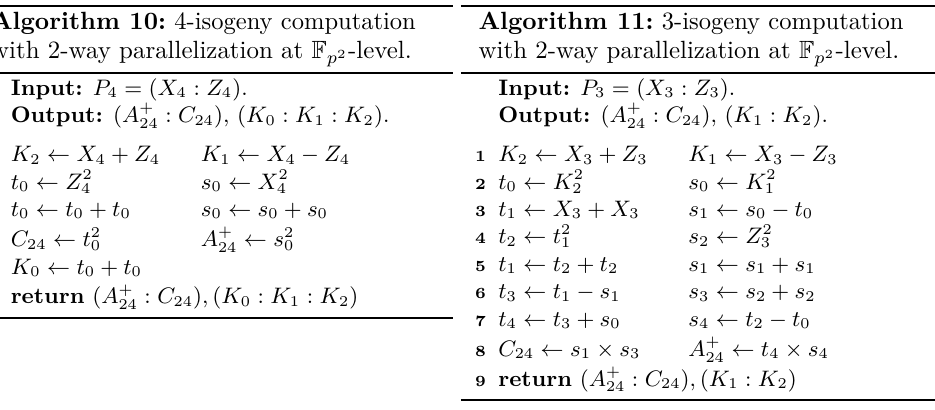
Algorithm 10: 4-isogeny computation with 2-way parallelization at F